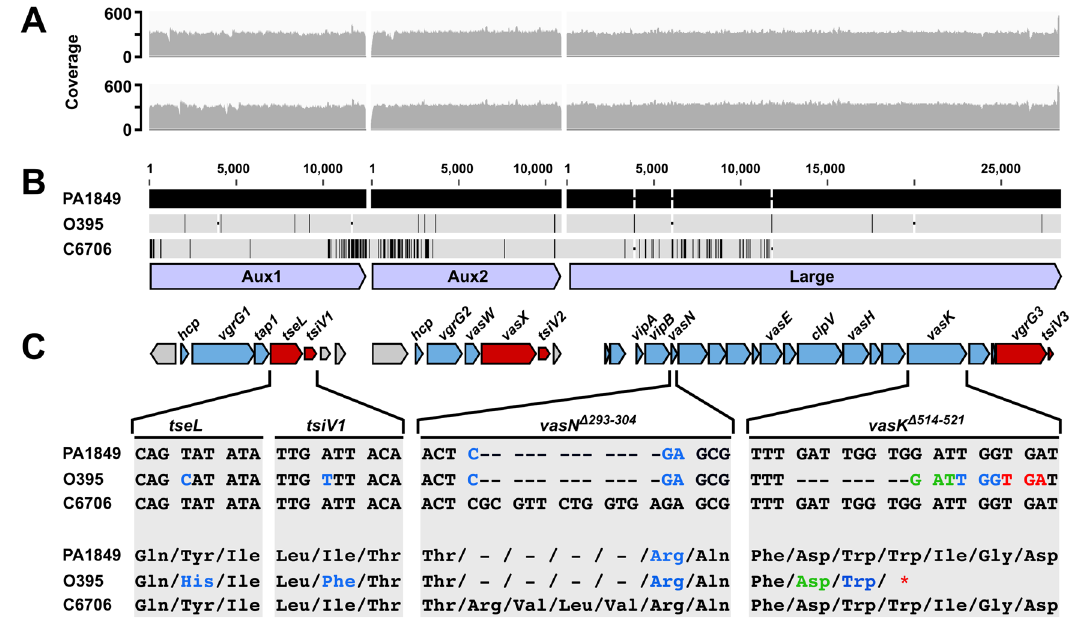
Fig. 1 The T6SS gene clusters of the classical V. cholerae strain PA1849. A Illumina-generated reads were mapped to a 6th pandemic classical strain (O395) and a 7th pandemic El Tor V. cholerae strain (C6706). Read coverage plotted against the nucleotide sequence of the three T6SS gene clusters (shown as light blue arrows in panel ( B )) separated by white vertical lines that indicate the intervening genomic sequences not included in this analysis. The top plot (grey) represents read coverage against the O395 reference, and the bottom plot (grey) represents read coverage against the C6706 reference. B Nucleotide alignment of the three T6SS clusters (bottom light blue arrows) from PA1849, O395 and C6706. The top black bars, representing the PA1849 T6SS clusters, are designated as the reference sequences. Conserved residues in O395 and C6706 sequences are represented by grey bars with single-nucleotide polymorphisms (SNPs) highlighted by vertical black lines and insertions or deletions (INDELS) of base pairs represented by gaps with horizontal black dashes. C A schematic gene map for each T6SS gene cluster displays structural genes as blue arrows and effector/immunity pairs as red arrows. Zoomed alignments of regions of interest in strains C6706, O395 and PA1849 are shown. Hyphens in the alignment indicate deleted nucleotides (above) and amino acids (below). Nucleotides and their corresponding amino acid changes are coloured. Multiple colours are used to indicate the new reading frame for the vasK frameshift mutation. Reads mapping to the vasN deletion are shown in the Supplementary material (Supplementary Fig.